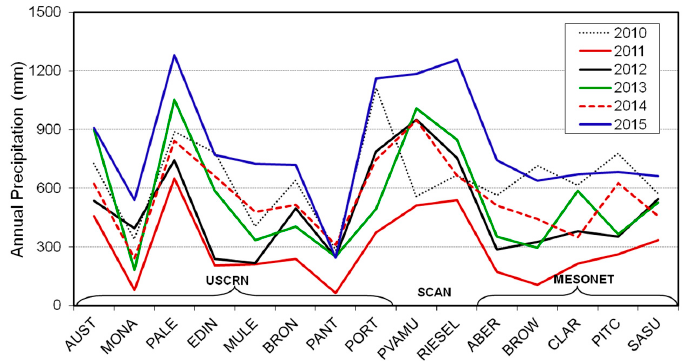
Figure 3. Annual precipitation at selected stations (2010–2015).